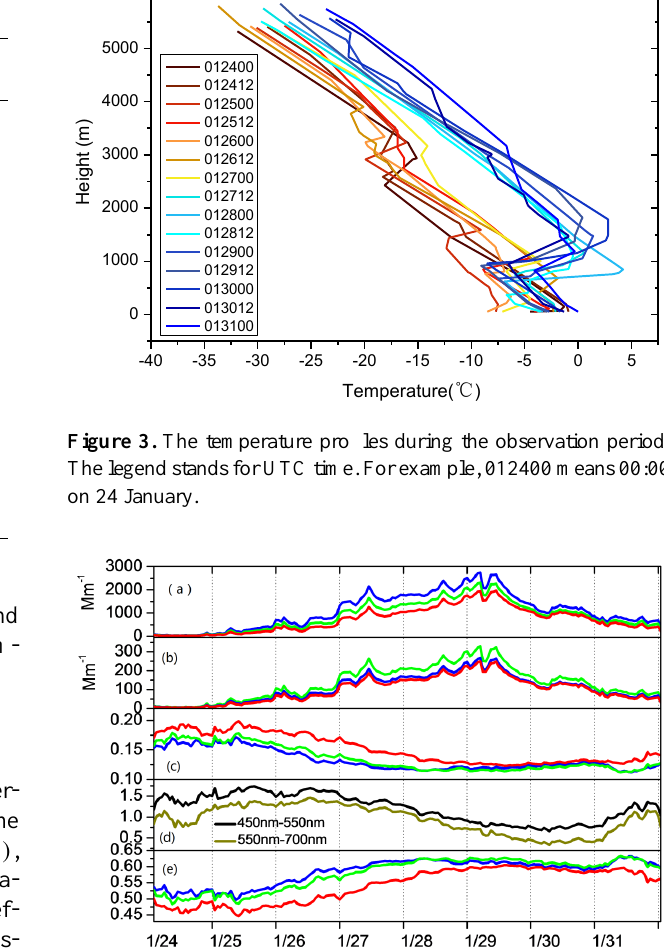
cles. It is related to particle size distribution and can be cal-